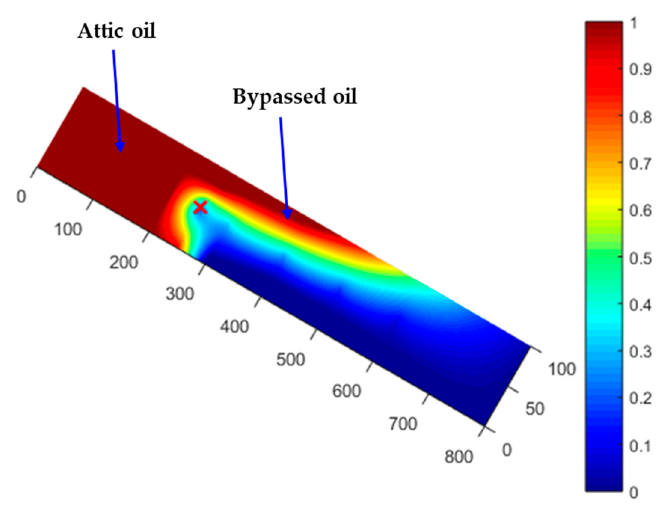
Figure 5. The oil distribution after water flooding in the longitudinal section.